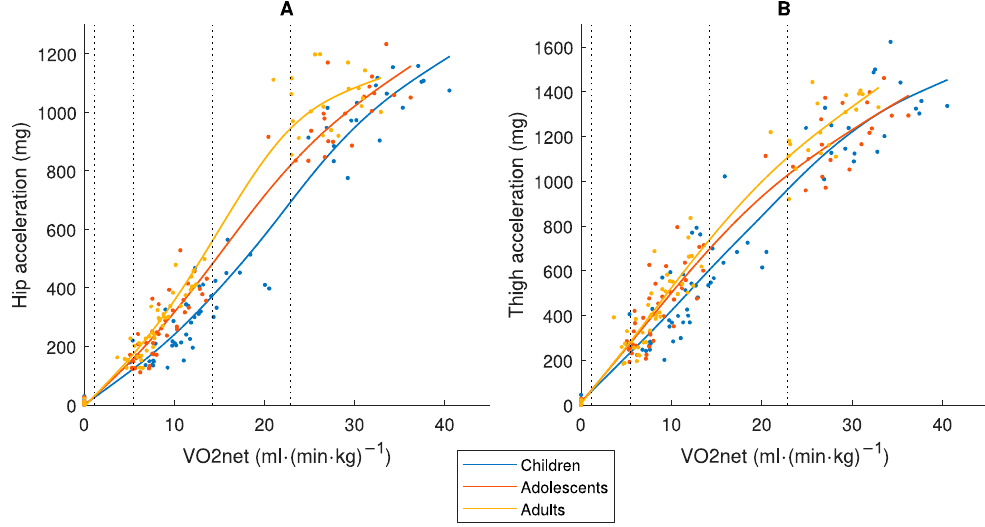
Figure 5. Calibration of accelerometer measures of absolute PA intensity (mg) for ( A ) hip and ( B ) thigh placement in children 9–11, adolescents 14–16 and adults 23–44 years old, using the common VO 2net cut-points defined and presented in Figure 4.